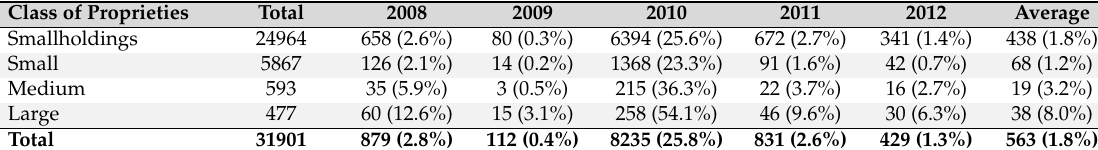
Table A7. Number of proprieties affected by fires through the years.